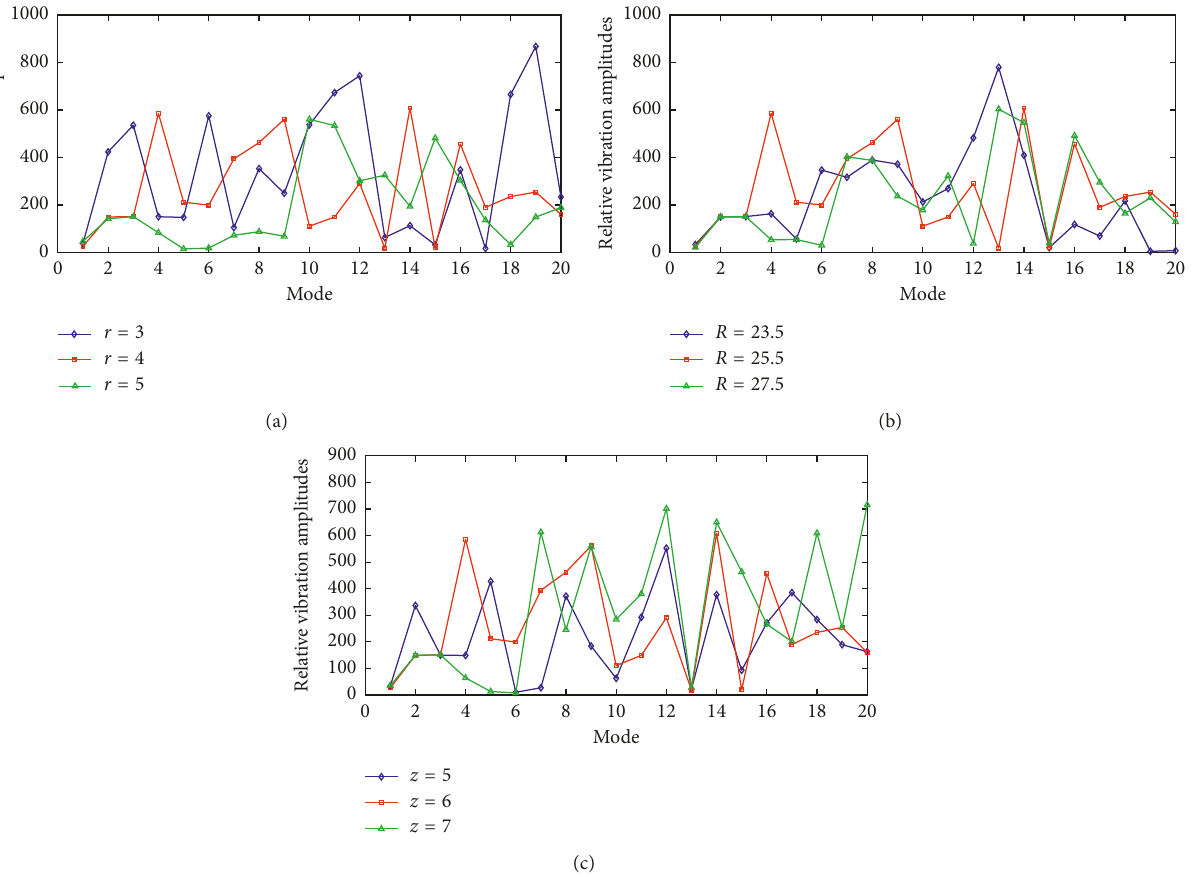
Figure 11: Vibration amplitudes of the second-step output shaft as functions of the system